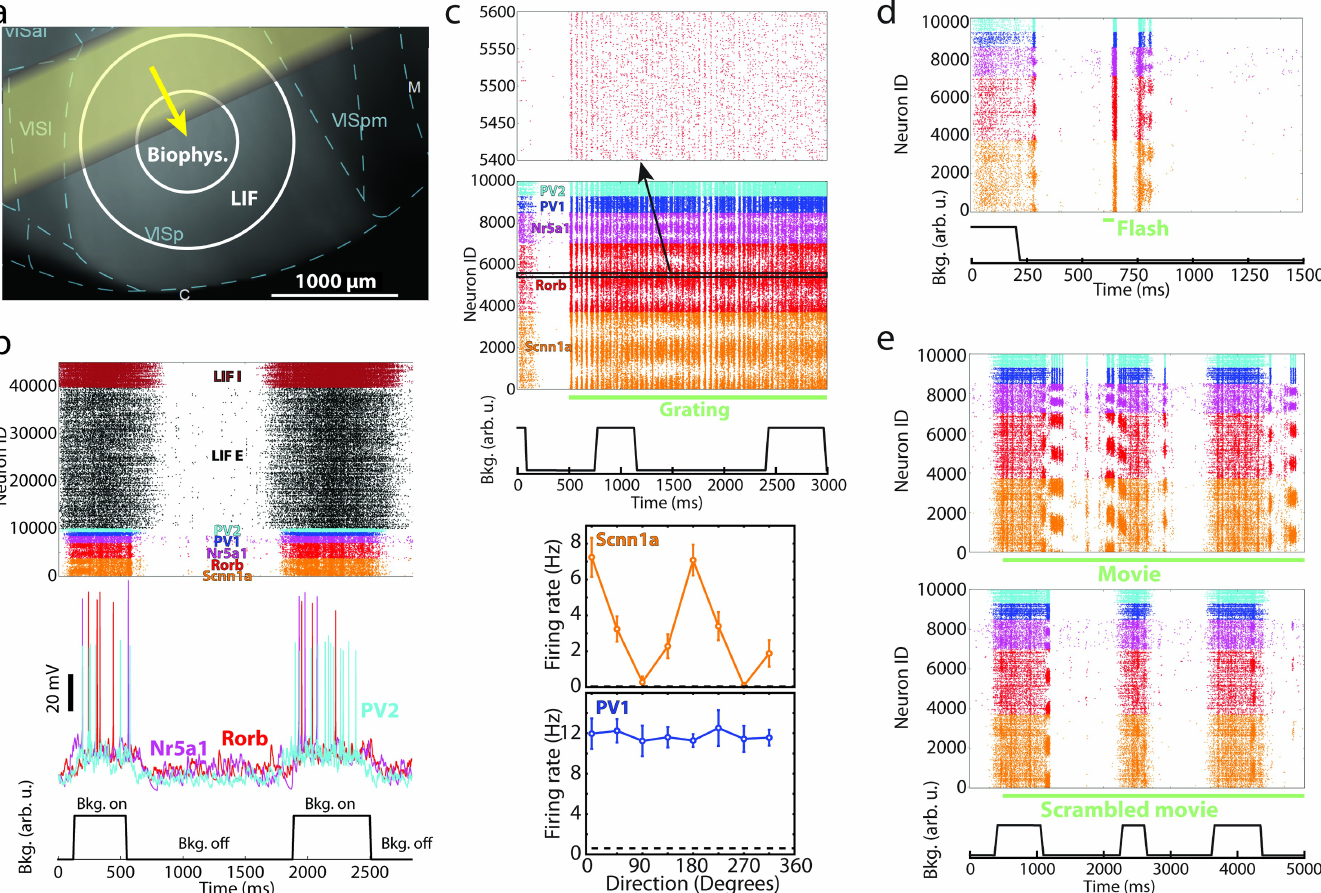
Fig 2. Examples of simulated responses to various visual stimuli. (a) Spontaneous activity in the model was generated by waves of background excitation (“Bkg. on”, yellow arrow denotes the direction of motion of the yellow bar-like region) alternated with intervals of no background excitation (“Bkg. off”). (b) Model activity in a gray screen trial. Examples of membrane potential traces from simulated biophysical cells are in the middle. (c) Spike raster in response to a drifting grating (TF = 4 Hz, at 0 degrees direction). Bottom, example orientation tuning curves for an excitatory and inhibitory cell from simulation. (d) Spikes in response to a 50 ms full-field flash. (e) Spike raster for a single trial of a natural movie (top) and for a temporally scrambled version of the same movie (bottom). The raster in (b) shows all neurons and those in (c-e) for clarity show the 10,000 cells in the biophysical core of the model (inset on top of (c) zooms in on 200 cells). All rasters are examples from one trial; all trials used unique combinations of “Bkg. on” and “Bkg. off” states (shown at the bottom of plots), which overlapped (or not) in different ways with the visual stimuli.